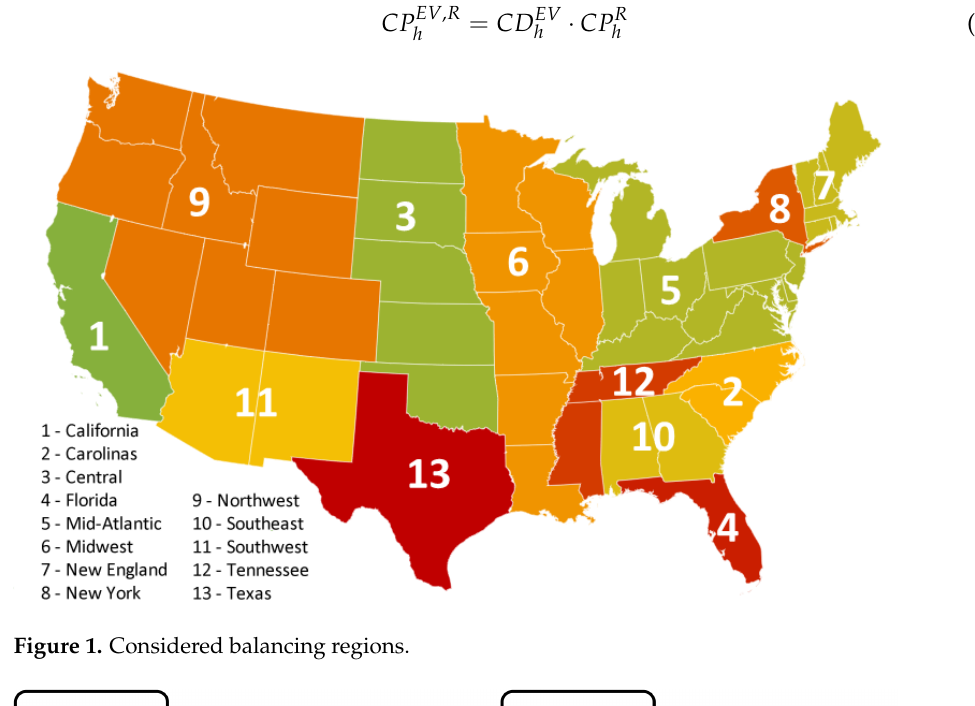
Figure 1. Considered balancing regions.